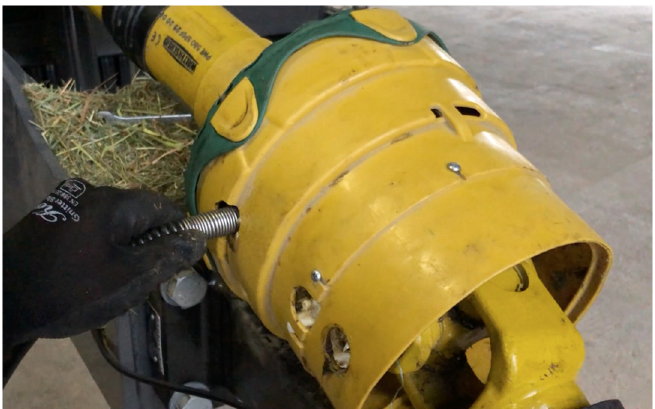
Figure 8. Lubrication through an access hole in the shaft guard of the PTO shaft [own photography].